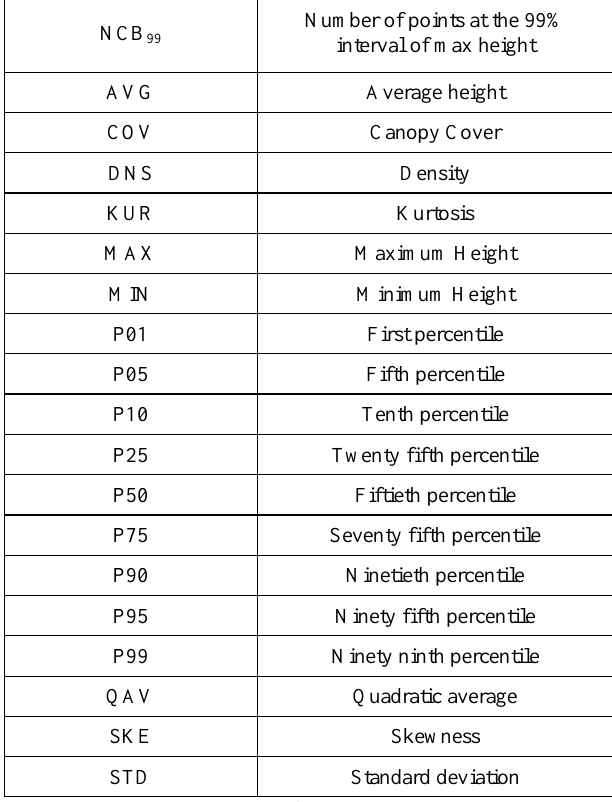
Table 1. Summary of the LiDAR derivatives